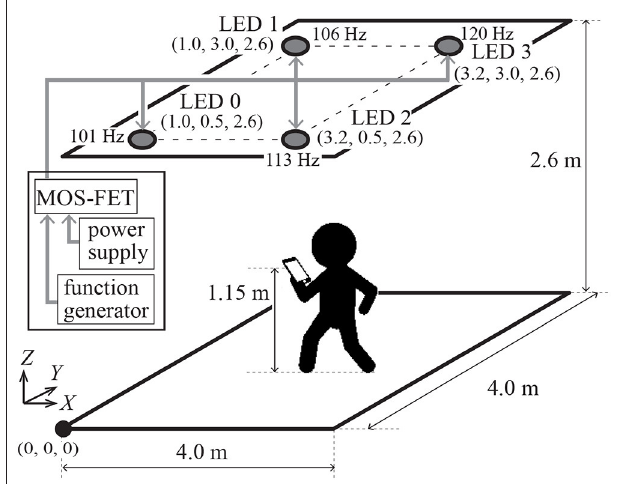
FIGURE 4 | Positioning of the LEDs in the room and the camera